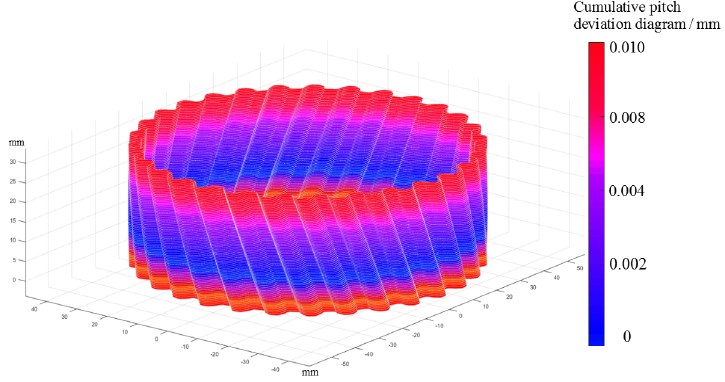
Figure 17. Color map of the overall pitch deviation on the full tooth surface.